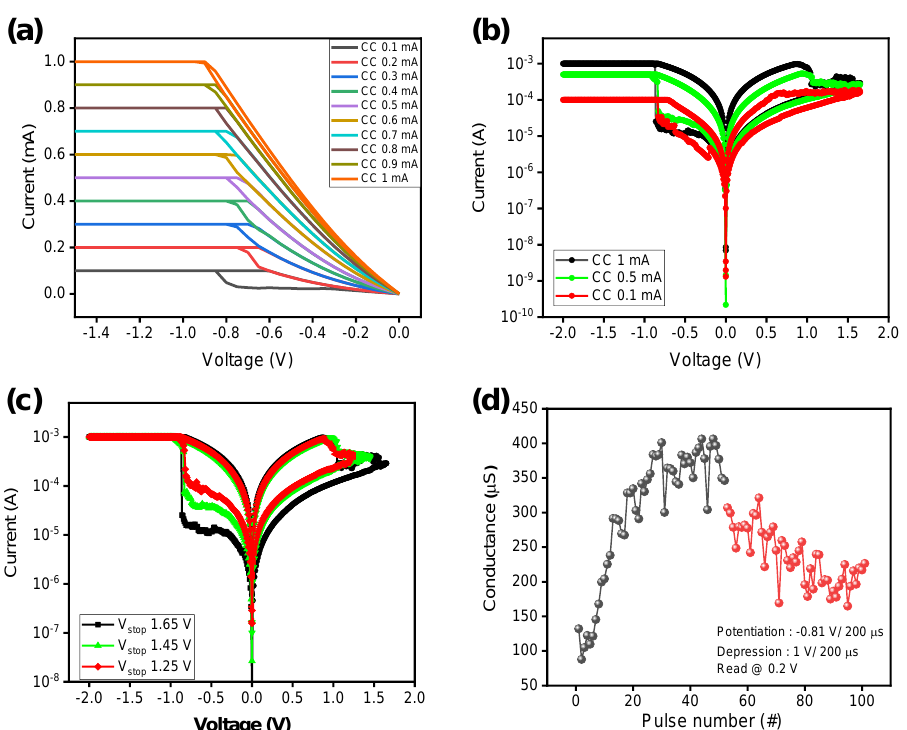
Figure 4. The MLC characteristics of the Pt/SiO X /TaN RRAM device: ( a ) plots of the low-resistance current with various compliance currents; (b and c) controlling the bipolar resistive switching via ( b ) the compliance current and ( c ) the reset stop voltage; ( d ) potentiation (black) and depression (red) by the application of negative and positive pulses, respectively.